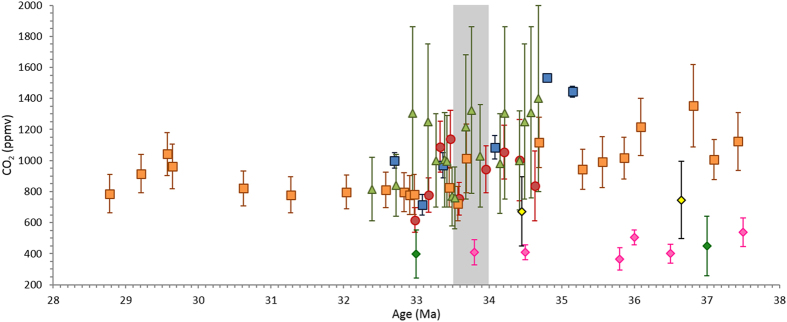
Compilation of published atmospheric pCO2 reconstructions crossing the EOT.Symbols denote different proxies: circles = boron isotopes (red4), diamonds = stomatal indices (yellow99; dark green100101; pink12), squares = alkenones (blue5; orange102) and triangles = diatom carbon isotopes (green). The CO2 drawdown and minima associated with the EOT is located at 33.7–33.5 Ma in the Pearson et al.4, Zhang et al.102 and Heureux and Rickaby103 records.